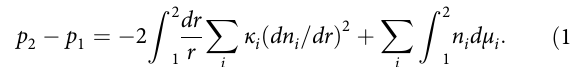
Fig. 2 Bulk portion of the free energy. Shown is the contour plot of the presently employed bulk free energy density Vð n 1 ; n 2 Þ , see Eq. (6), as a function of the concentrations n 1 and n 2 of the components. The two paraboloids correspond with the free energies of the two pure phases, respectively; the paraboloids intersect at the “ dividing surface ” shown in the plot by the dashed yelow line. The upper-left minimum corresponds to the dimer-rich solution, which is the minority phase. The curve connecting the two minima is the parametric plot of the concentrations n 1 and n 2 from Fig. 1, the parameter being the radial coordinate for a liquid mixture, in spherical geometry 36 :